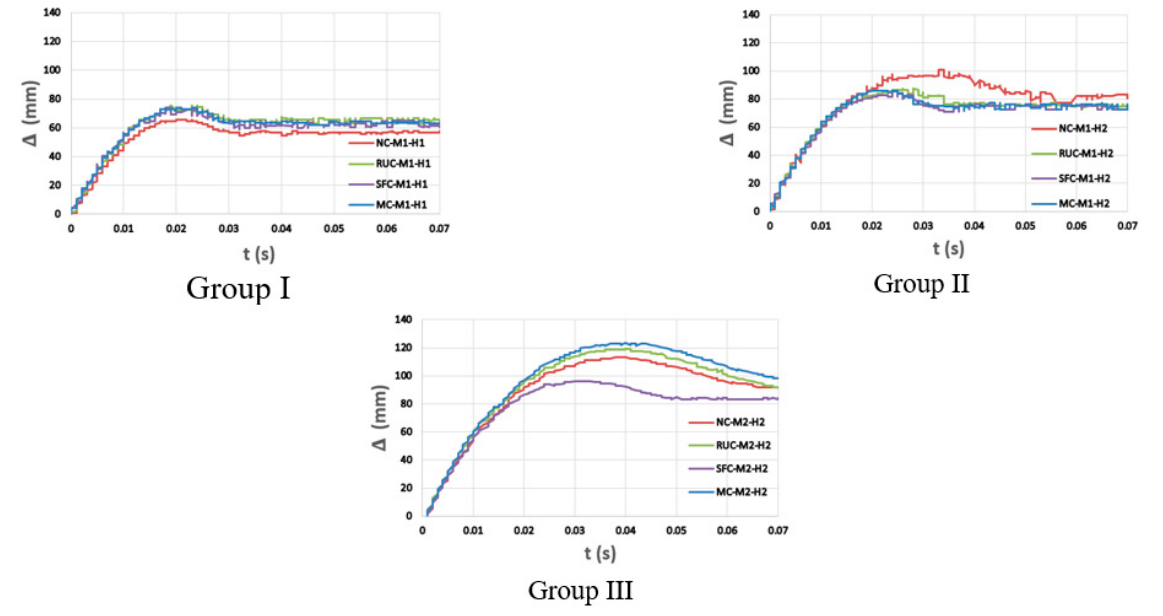
Figure 5. Time-history of mid-span deflection curves.